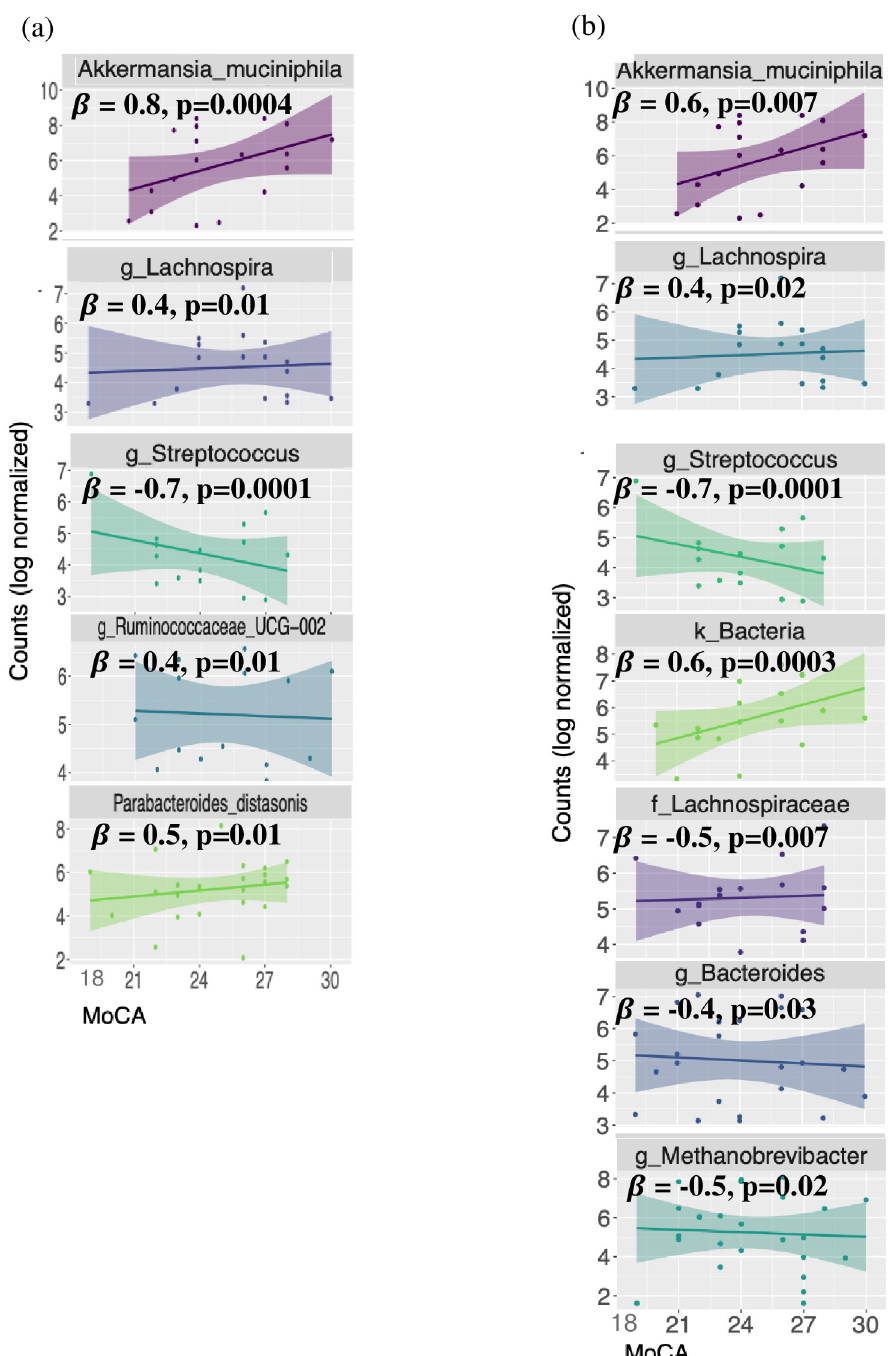
Fig 5. Log normalized counts of ASVs significantly associated with MoCA score. (a) Scatter plots of log normalized counts versus MoCA score for the 5 differentially abundant ASVs. The taxonomies shown provide the lowest known taxonomic level. For example, the ASV identified as k_Bacteria was only identifiable down to the kingdom level of Bacteria. β ’s correspond to beta coefficients from the zero-inflated unadjusted linear model. Scatter plots are overlayed with a linear regression line to assist in pattern visualization. (b) Same as part (a) except these ASVs are the differentially abundant ASVs from the adjusted model, which was adjusted by College Graduate (Y/N), usage of microbiome-altering and anti-inflammatory medication. Abbreviations: ASV—Amplicon Sequence Variant; MoCA— Montreal Cognitive Assessment.